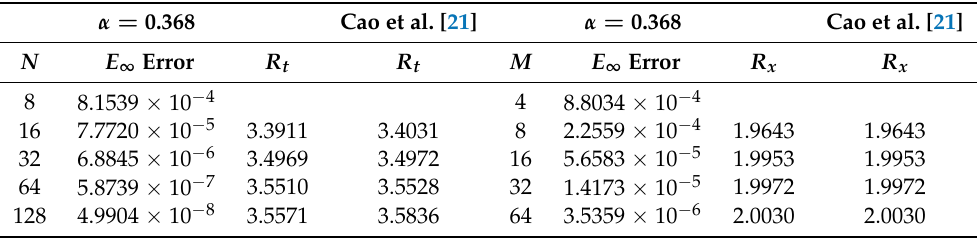
Table 10. The maximum errors and convergence rates R t for Example 5.1 in [21], when h = 1/6000, and spatial convergence rates R x , when τ =